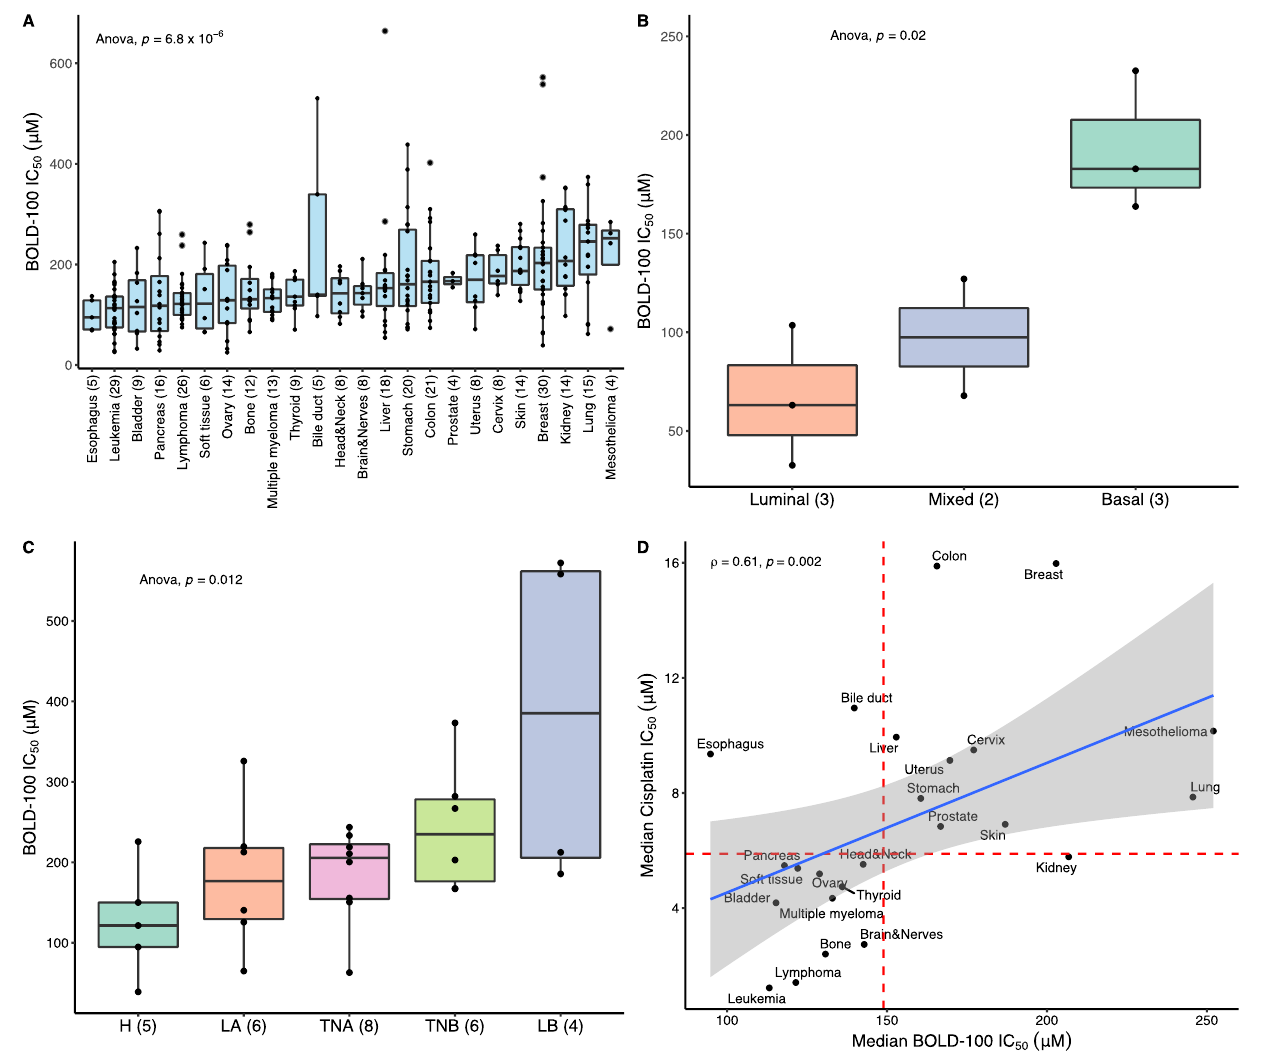
Figure 1. Sensitivity profile in BOLD-100 across a cancer cell line panel. 319 cancer cell lines were treated with BOLD-100 or cisplatin and the IC 50 was calculated. ( A ) The IC 50 distribution of BOLD- 100 was grouped by tissue lineages and ranked by median IC 50 . X-axis label indicates the tissue lineage (number of cell lines). ( B ) The IC 50 distribution of BOLD-100 across the subtypes of bladder cancer ( n = 9), classified into basal, mixed, or luminal subtypes. The IC 50 for one cell line (HT-1376) with a subtype classification of ‘mixed’ could not be computed as it was above the concentration range tested. ( C ) The IC 50 distribution of BOLD-100 across the subtypes of breast cancer ( n = 30), classified into luminal A (LA), luminal B (LB), HER2+ (H), triple negative A (TNA), and triple negative B (TNB). The IC 50 for one cell line (BT-483) with a subtype classification of LA could not be computed as it was above the concentration range tested. ( D ) Comparison of the within-tissue IC 50 median for BOLD-100 and cisplatin treatment. The red bisecting lines represent the pan-cancer median IC 50 for each treatment across the cell panel (149 µ M for BOLD-100 and 5.89 µ M for cisplatin). The blue line represents the linear line of best fit between the two distributions. The gray shaded area represents the 95% confidence interval for the linear line of fit. Spearman correlation coefficient ρ and corresponding p-value is shown. For the box plots, the length of each box represents the range between the 25th and the 75th percentile whereas the whiskers represent the threshold for outlier values ( A – C ). For boxplots of cancer subtypes, the x-axis label indicates the subtypes (number of cell lines) ( B , C ). Within-tissue median IC 50 values were used to directly compare the sensitivity profiles of BOLD-100 and cisplatin (Figure 1D). A moderately positive correlation was